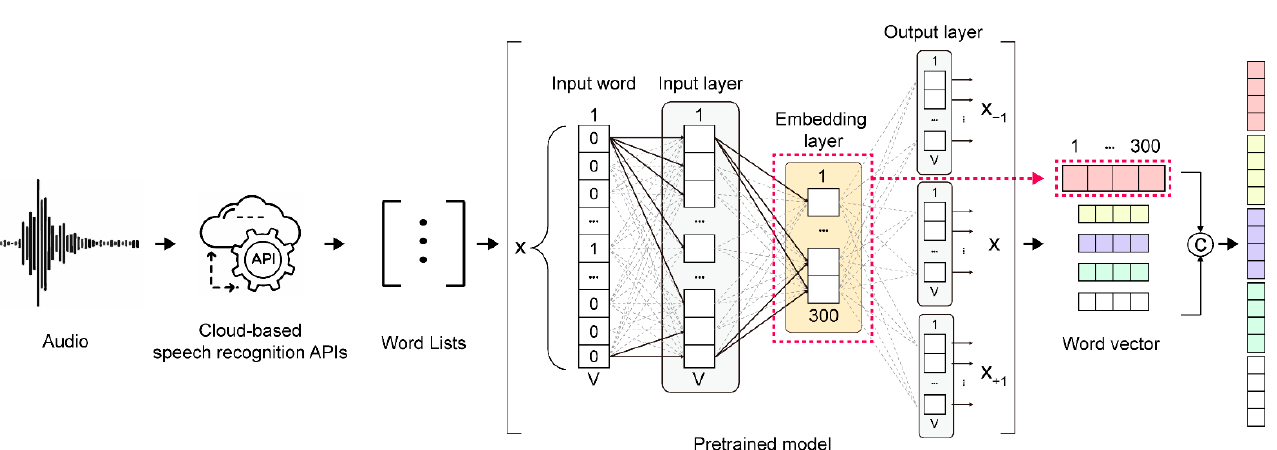
Figure 2. Block diagram of the proposed audio speech recognition module.